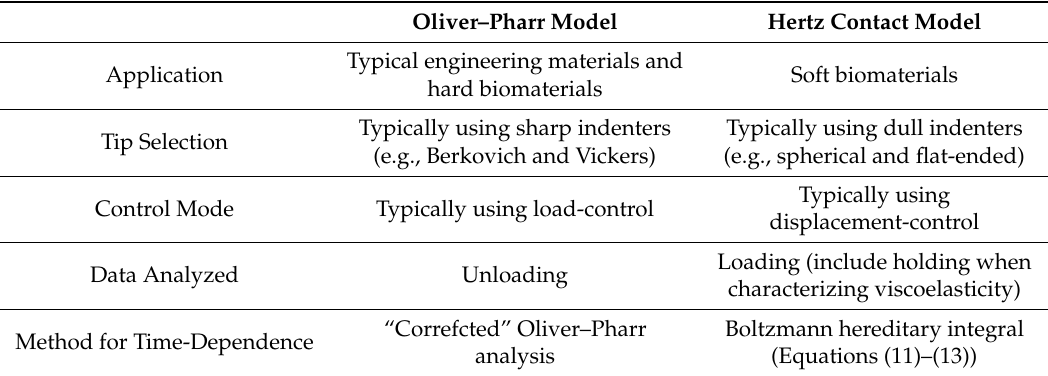
Table 1. Comparisons between the Oliver–Pharr method and Hertz contact